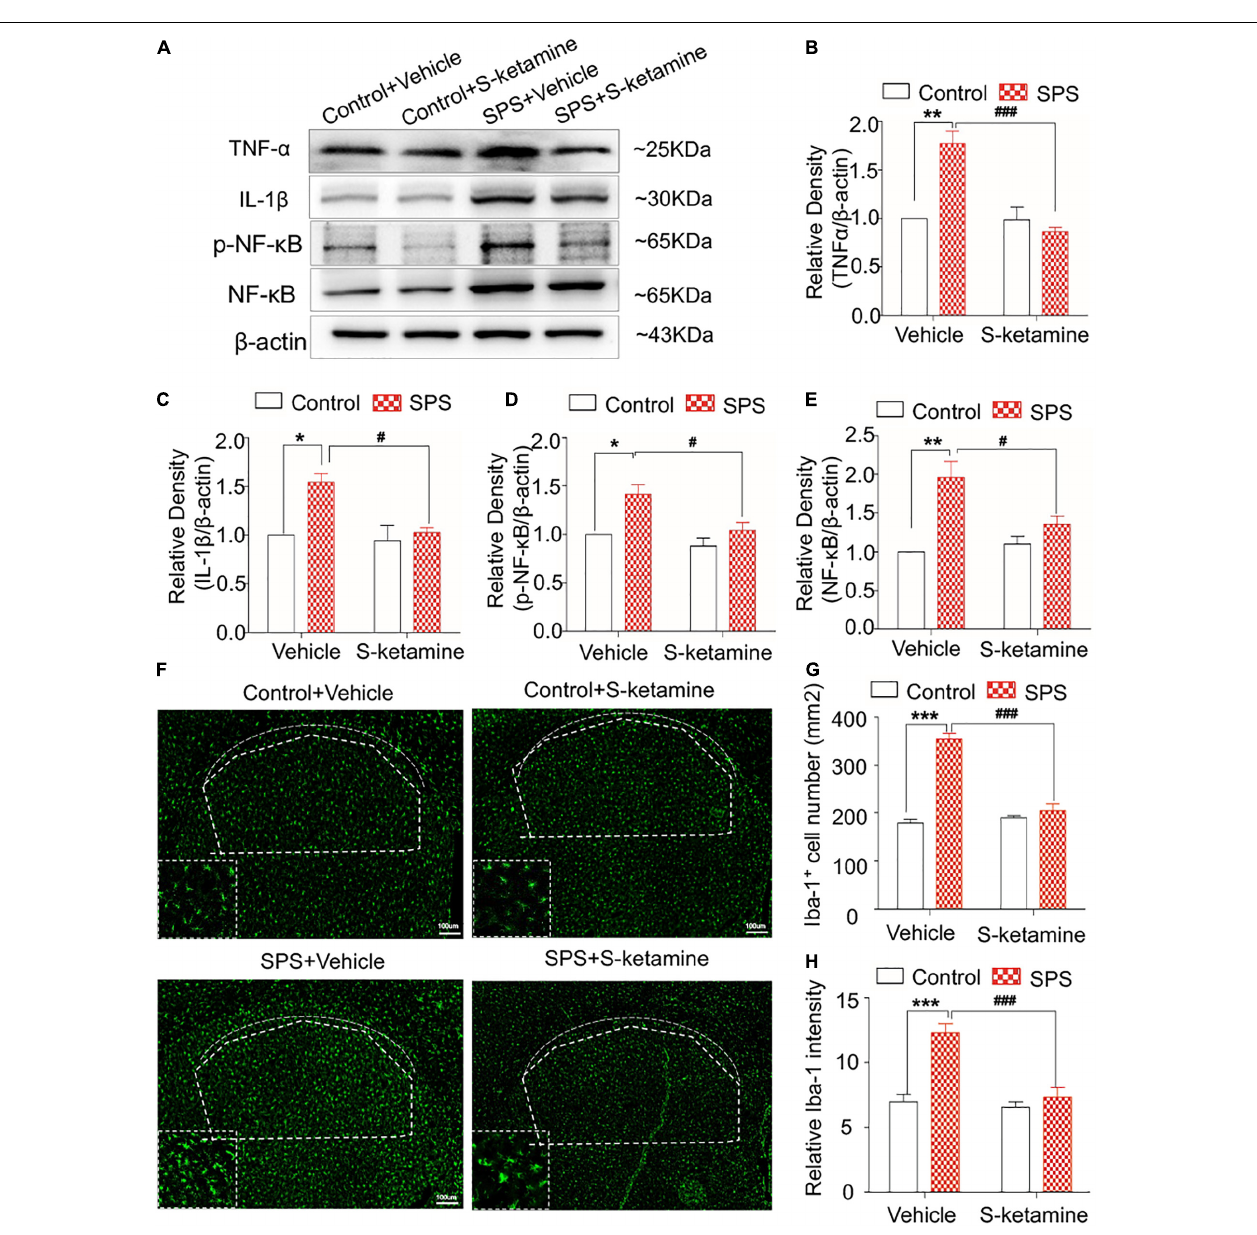
FIGURE 5 | S-ketamine alleviates microglial activation and downregulates pro-inflammatory cytokines in the dorsal striatum. Rats were randomly assigned into control + vehicle group, SPS + vehicle group, control + S-ketamine 5 mg/kg group and SPS + S-ketamine 5 mg/kg group. n = 3 per group. (A) Protein levels of TNF- α , IL-1 β , p-NF- κ B, and NF- κ B in the dorsal striatum. Relative intensity of TNF- α (B) , IL-1 β (C) , p-NF- κ B (D) , and NF- κ B (E) in the dorsal striatum. (F) Immunofluorescence staining of Iba-1 in the dorsal striatum. (G) The number of Iba-1-positive stained cells in the dorsal striatum. (H) Relative intensity of Iba-1-positive stained cells in the dorsal striatum. * P < 0.05, ** P < 0.01, and *** P < 0.001, control + vehicle group vs. SPS + vehicle group; # P < 0.05, ### P < 0.001, SPS + S-ketamine 5 mg/kg group vs. SPS + vehicle